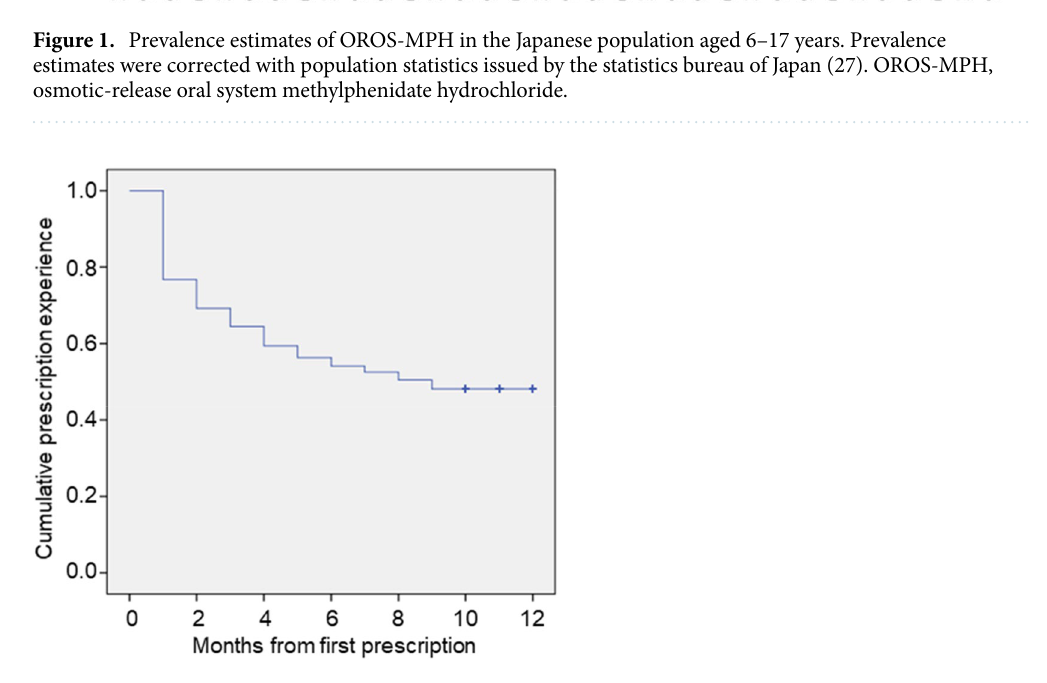
Figure 2. Kaplan–Meier survival curve for prescription